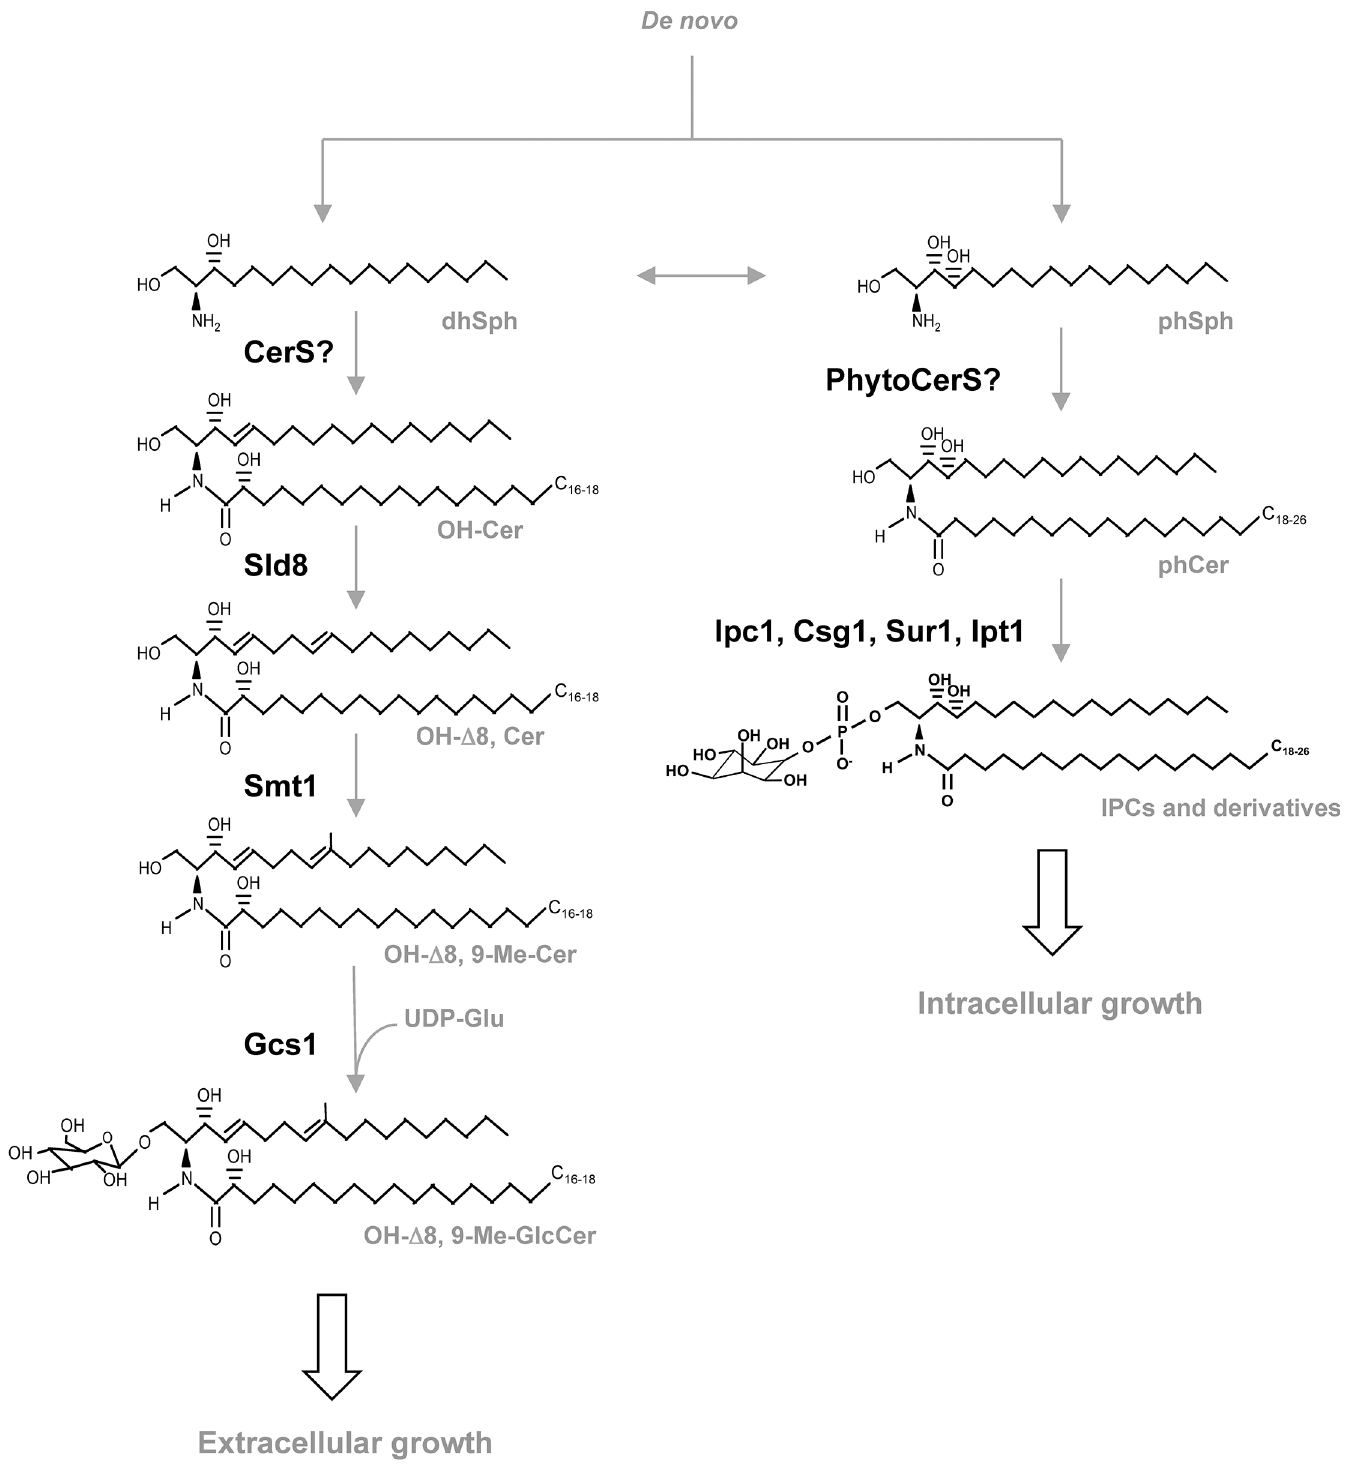
Fig 2. Glycosphingolipid pathway in fungi. dhSph, dihydrosphingosine; CerS, ceramide synthases; OH-Cer, α -hydroxy-ceramide; Sld8, Δ 8 desaturase; OH- Δ 8-Cer, α -hydroxy- Δ 8-ceramide; Smt1, C9-methyl transferase; OH- Δ 8, 9-Me-Cer, α -hydroxy- Δ 8, 9-methylceramide; Gcs1, glucosylceramide synthase 1; OH- Δ 8, 9-Me-GlcCer, α -hydroxy- Δ 8, 9-methyl-glucosylceramide; phSph, phytosphingosine; PhytoCerS, phytoceramide synthases; phCer, phytoceramide; Ipc1, inositol-phosphoryl ceramide synthase 1; Csg1, mannosyl phosphorylinositol ceramide synthase regulatory protein; Sur1, mannosyl phosphorylinositol ceramide synthase; Ipt1, inositol phosphotransferase 1; IPC, inositol phosphoryl ceramide.